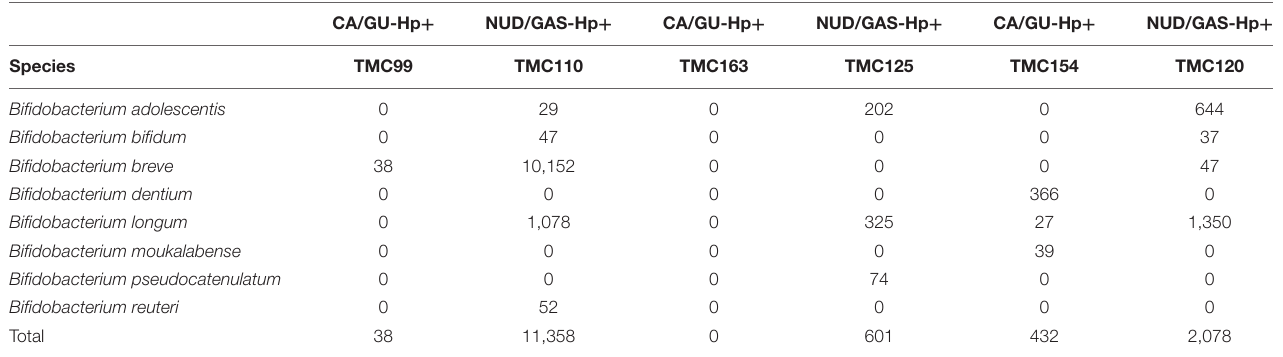
TABLE 4 | The read assignment to Bifidobacterium species in whole genome metagenome sequencing and analysis for three paired (age and sex matched) CA/GU-Hp + vs. NUD/GAS-Hp +